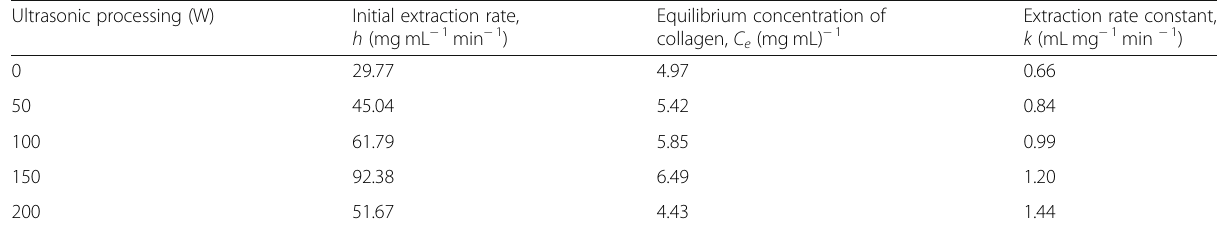
Table 1 Extraction rate constant, initial extraction rate and equilibrium concentration for different process conditions of ultrasonic extraction Ultrasonic processing (W)